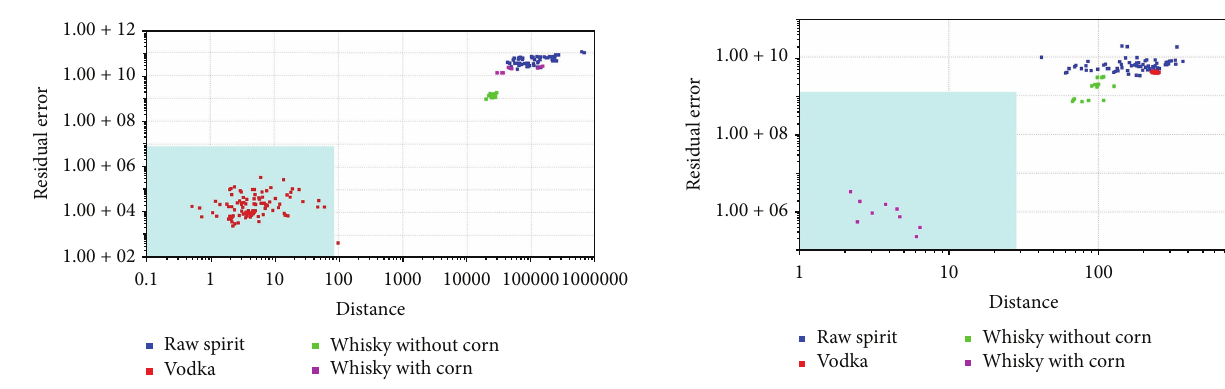
Figure 5: SIMCA analysis for vodkas, whiskies, and raw spirits: vodka, reference group.